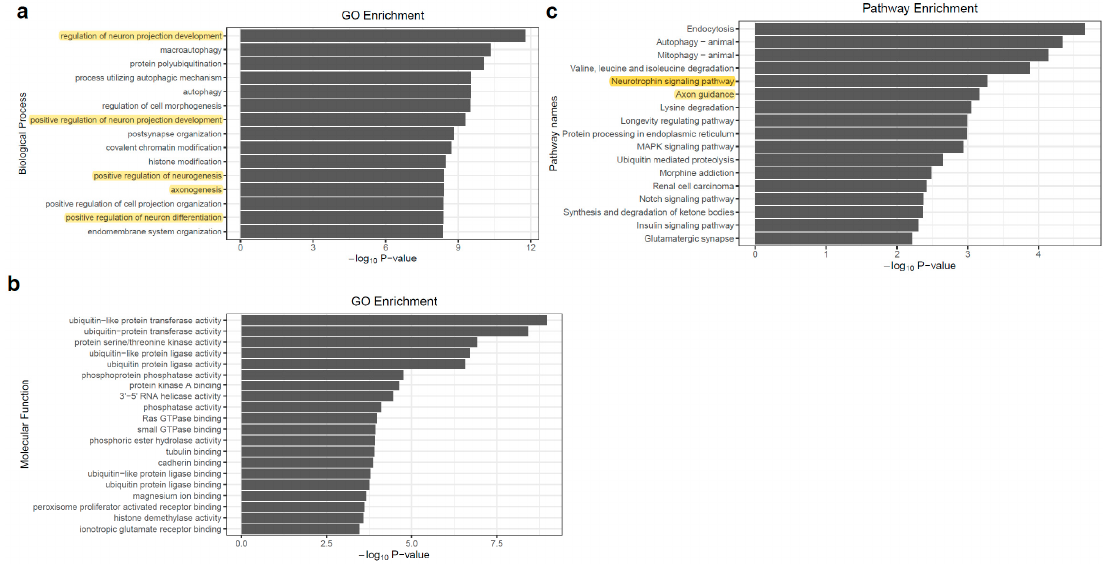
Figure 4. Enrichment of gene ontology annotation for the genes with significant changes of APA usage between two types of neurons. ( a ) Biological Process; ( b ) Molecular Function; ( c ) KEGG pathway.